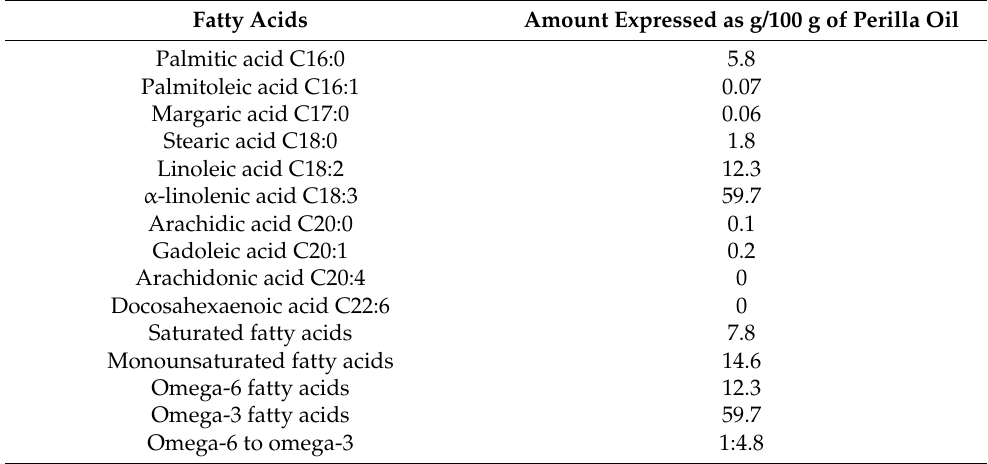
Table 1. Fatty acid composition of PO.